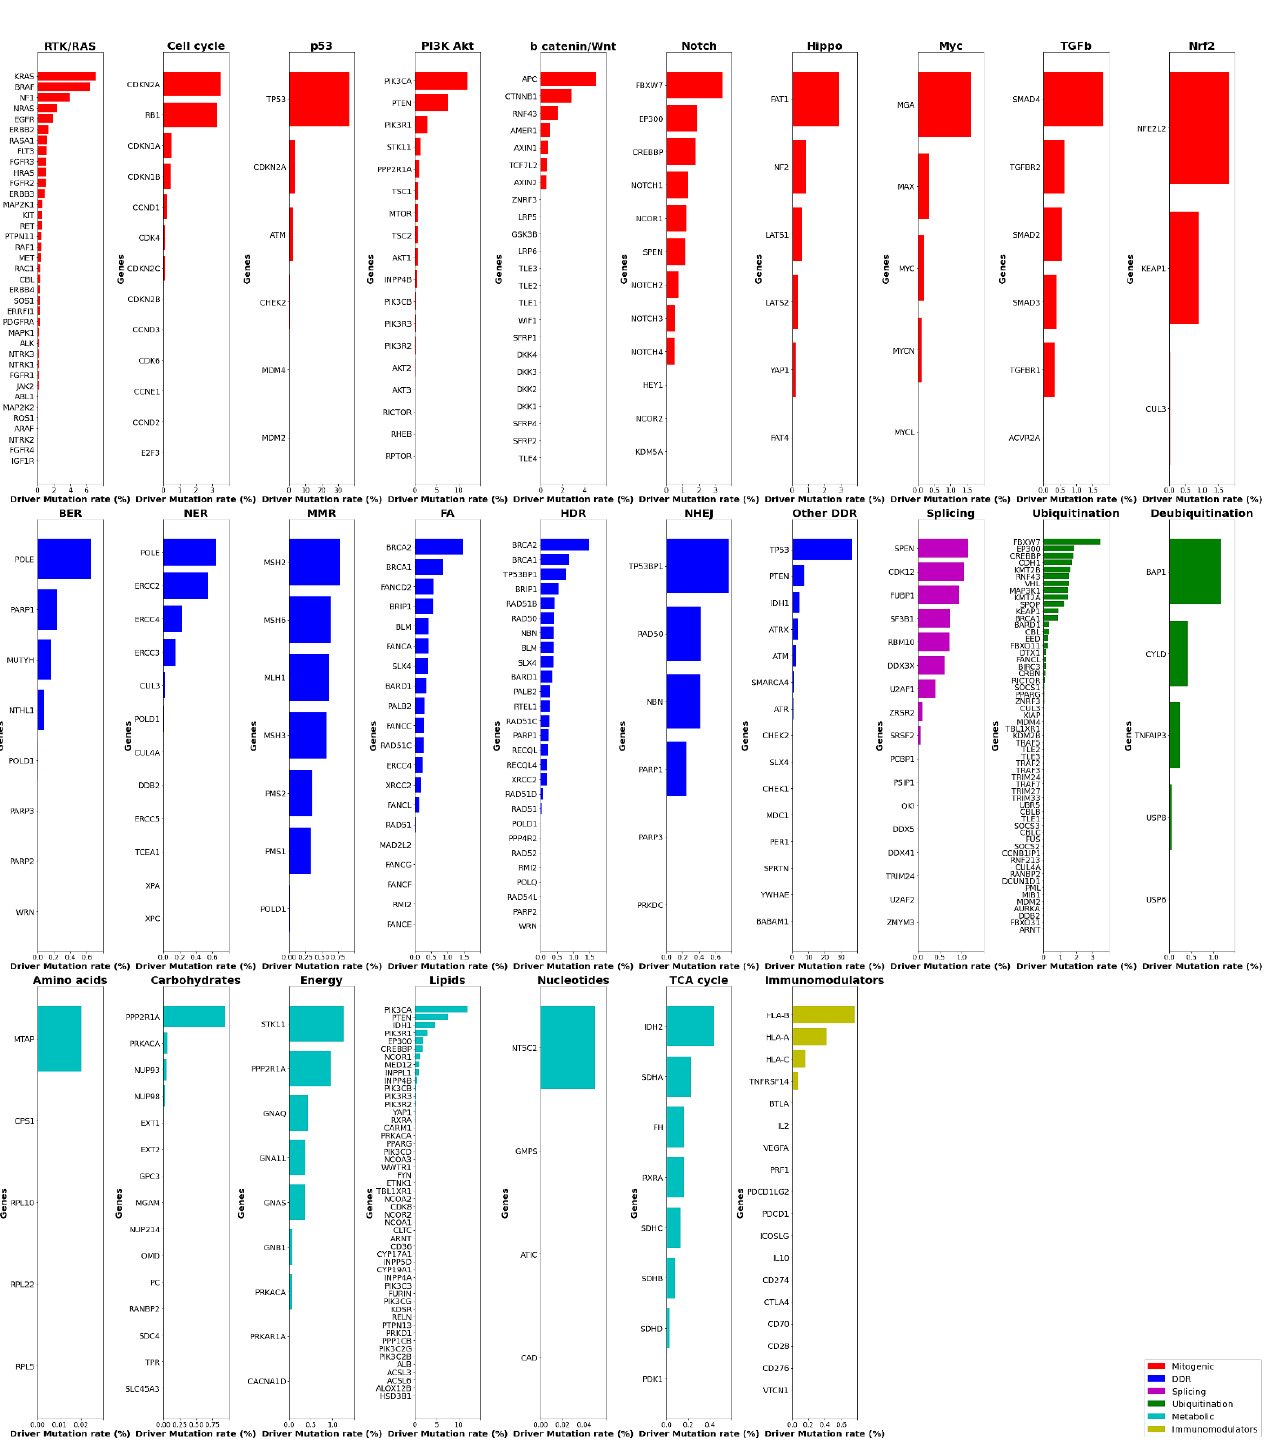
Figure 1. Somatic driver mutational frequency of 204 cancer genes involved in 27 signaling pathways implicated in six major cellular procedures. For the calculations, mutational data from 10,439 tumor samples were examined. Percentages refer to the total number of samples examined (10,439).